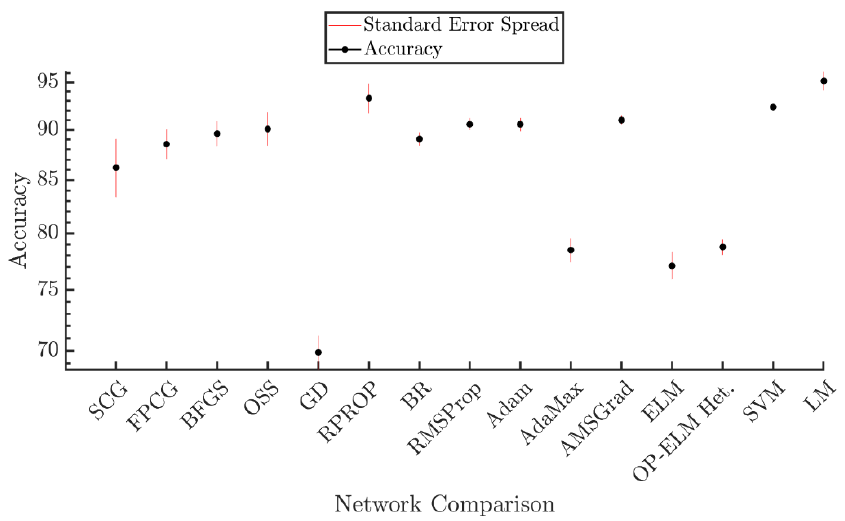
Figure 5. Statistical analysis of the results using a 95% CI. It can be seen from this figure that there is no overlap between the LM ‐ BP algorithm and the other approaches, which is a strong